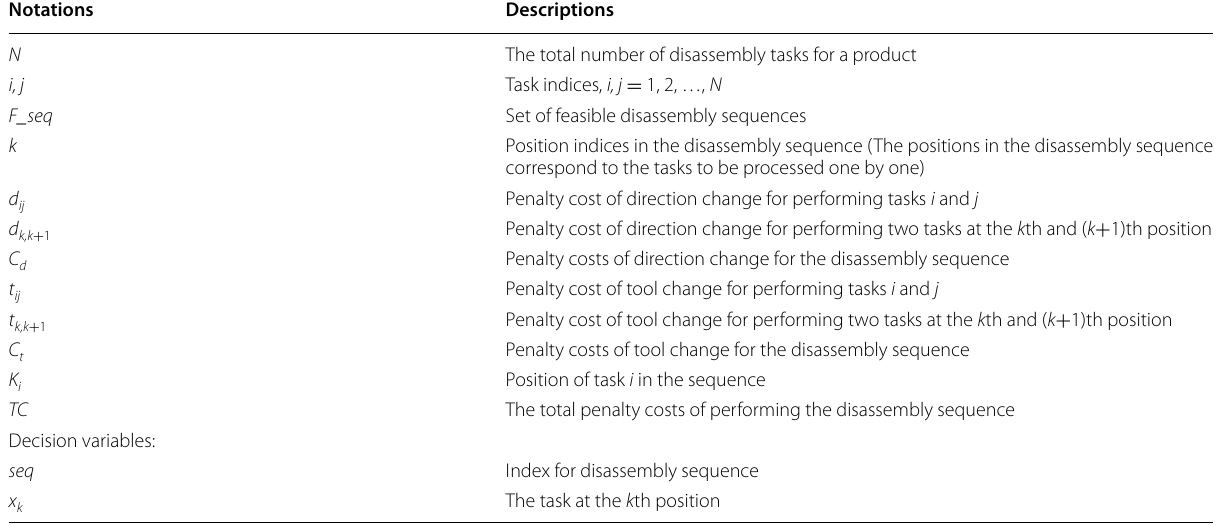
Table 1 The main notations defined in our model Notations